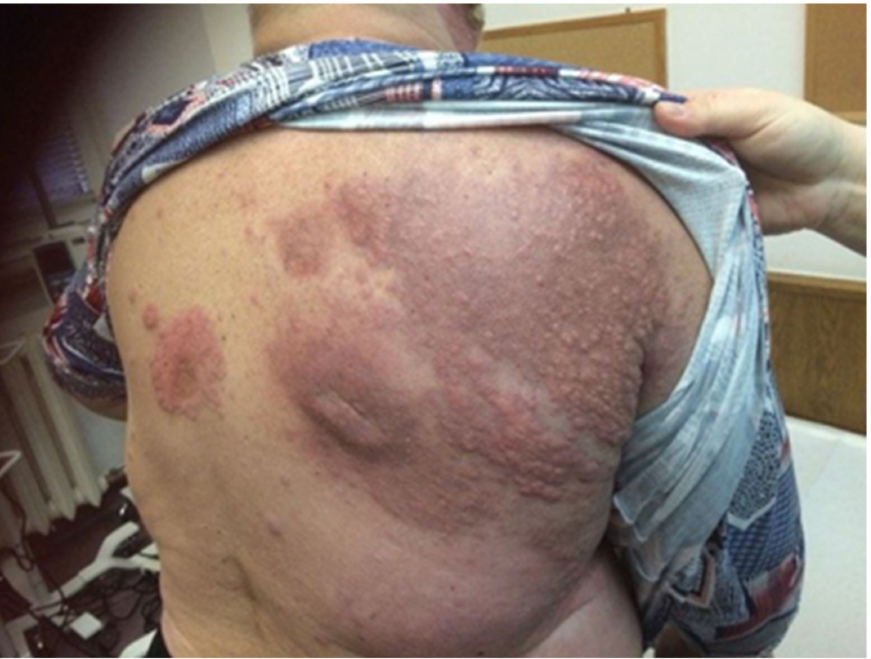
Figure 9. Extensive MCC skin lesions in patient with disease disseminated to skin and lungs (stage